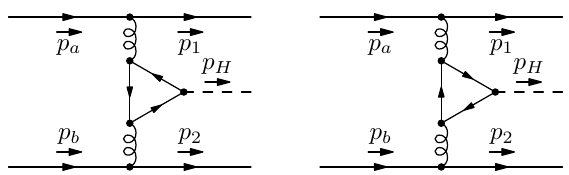
Figure 1 . Leading-order diagrams contributing to the process qQ